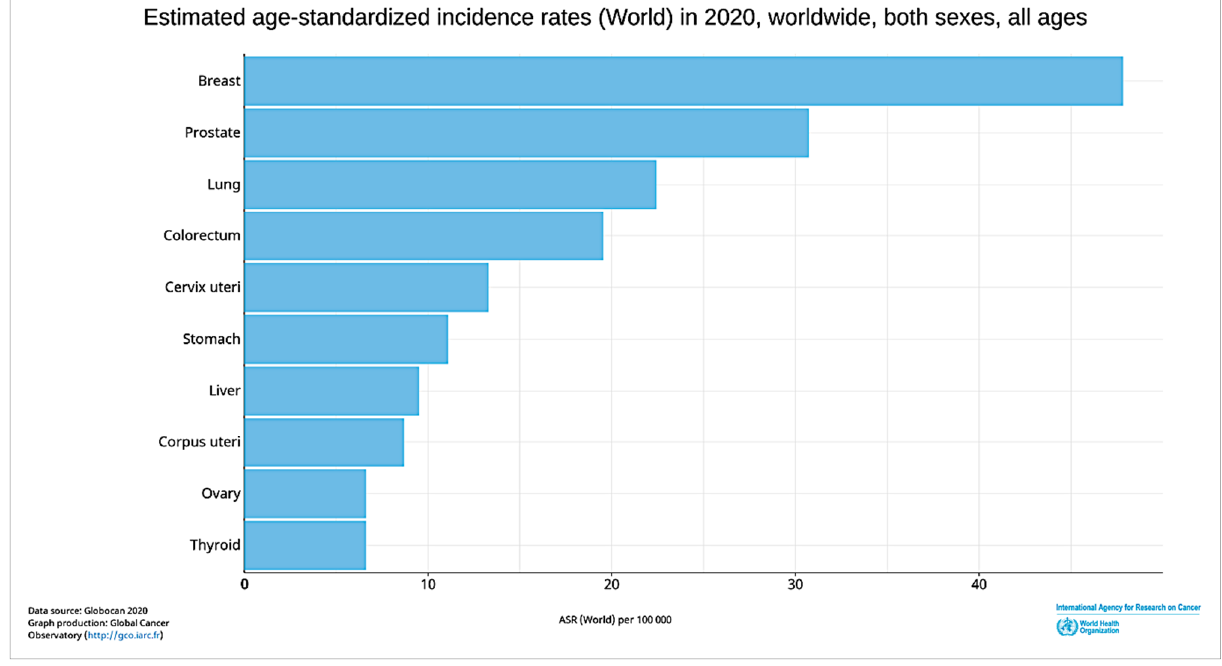
Figure 1. Incidence rates of cancer in 2020 [1].